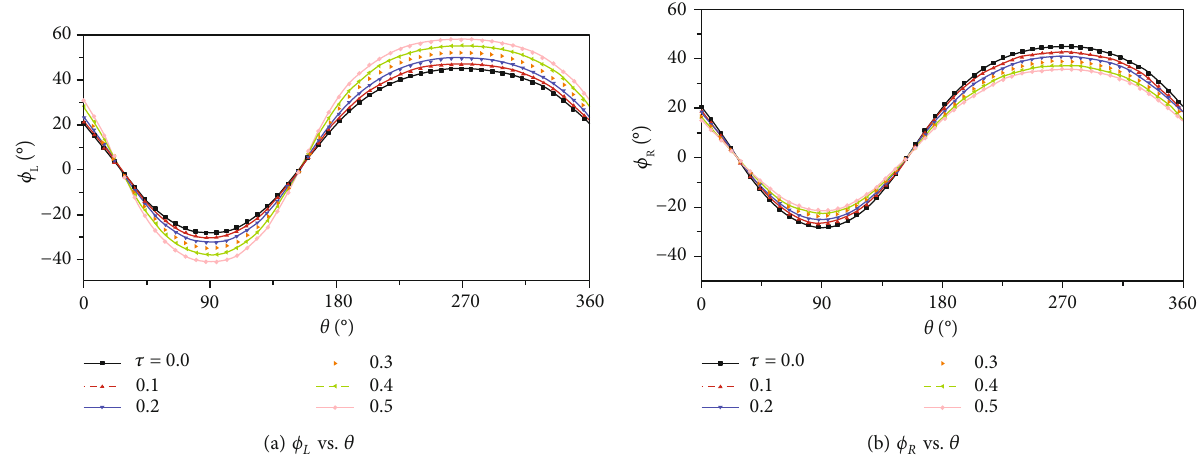
ϕ θ (SCSM). L and R versus